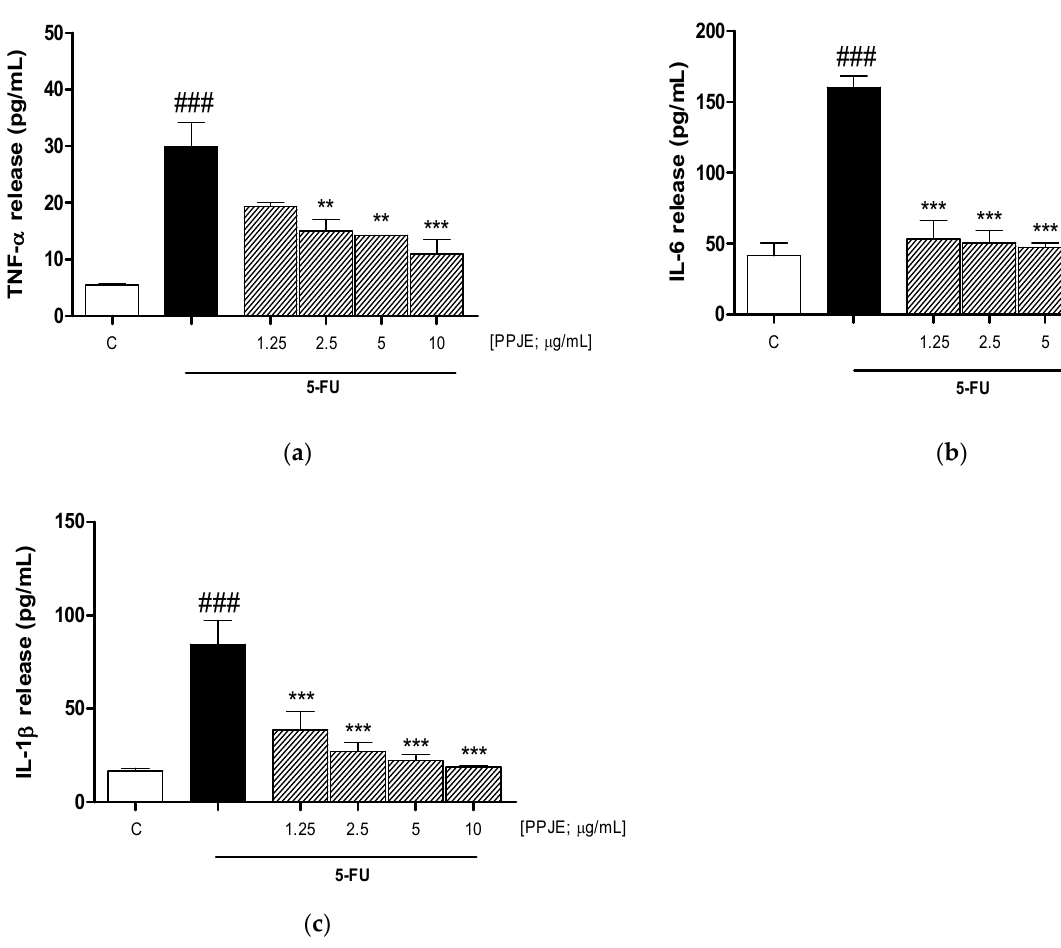
Figure 3. Effect of pomegranate juice extract (PPJE; 1.25–10 µg/mL) on TNF-α (tumor necrosis factor-α) ( a ), IL-6 (interleukin-6) ( b ) and IL-1β (interleukin-1β) ( c ), evaluated by ELISA assay, on HaCaT cells treated with 5-fluorouracil (5-FU; 10 µg/mL). Data are expressed as pg/mL of cytokine release. C denotes control group. ### denotes p < 0.001 vs. C; *** and ** denote respectively p < 0.001 and p < 0.01 vs. 5-FU.